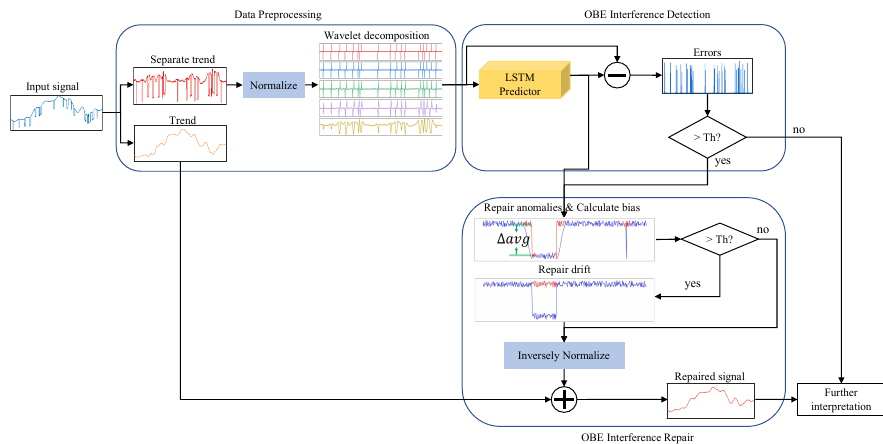
Figure 2. Overview of method